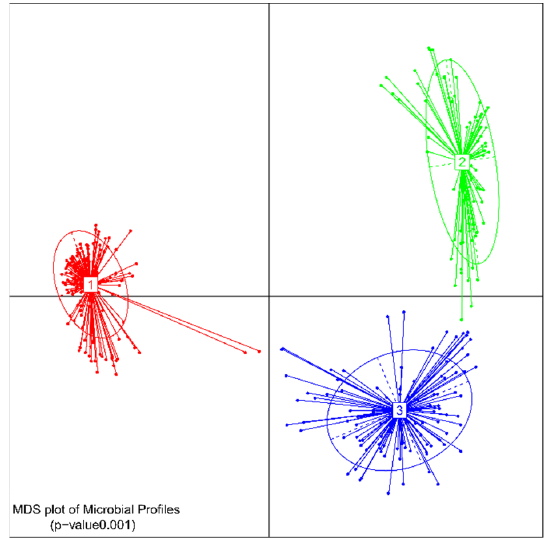
Figure 4. De novo clustering of all samples. Cluster 1 (red) shows the intestinal community of the hamsters before treatment, cluster 2 all treatment groups on day 3 as well as the Vancomycin-treated group throughout the study and cluster 3, all treatment groups from day 6 except the Vancomycin- treated group.